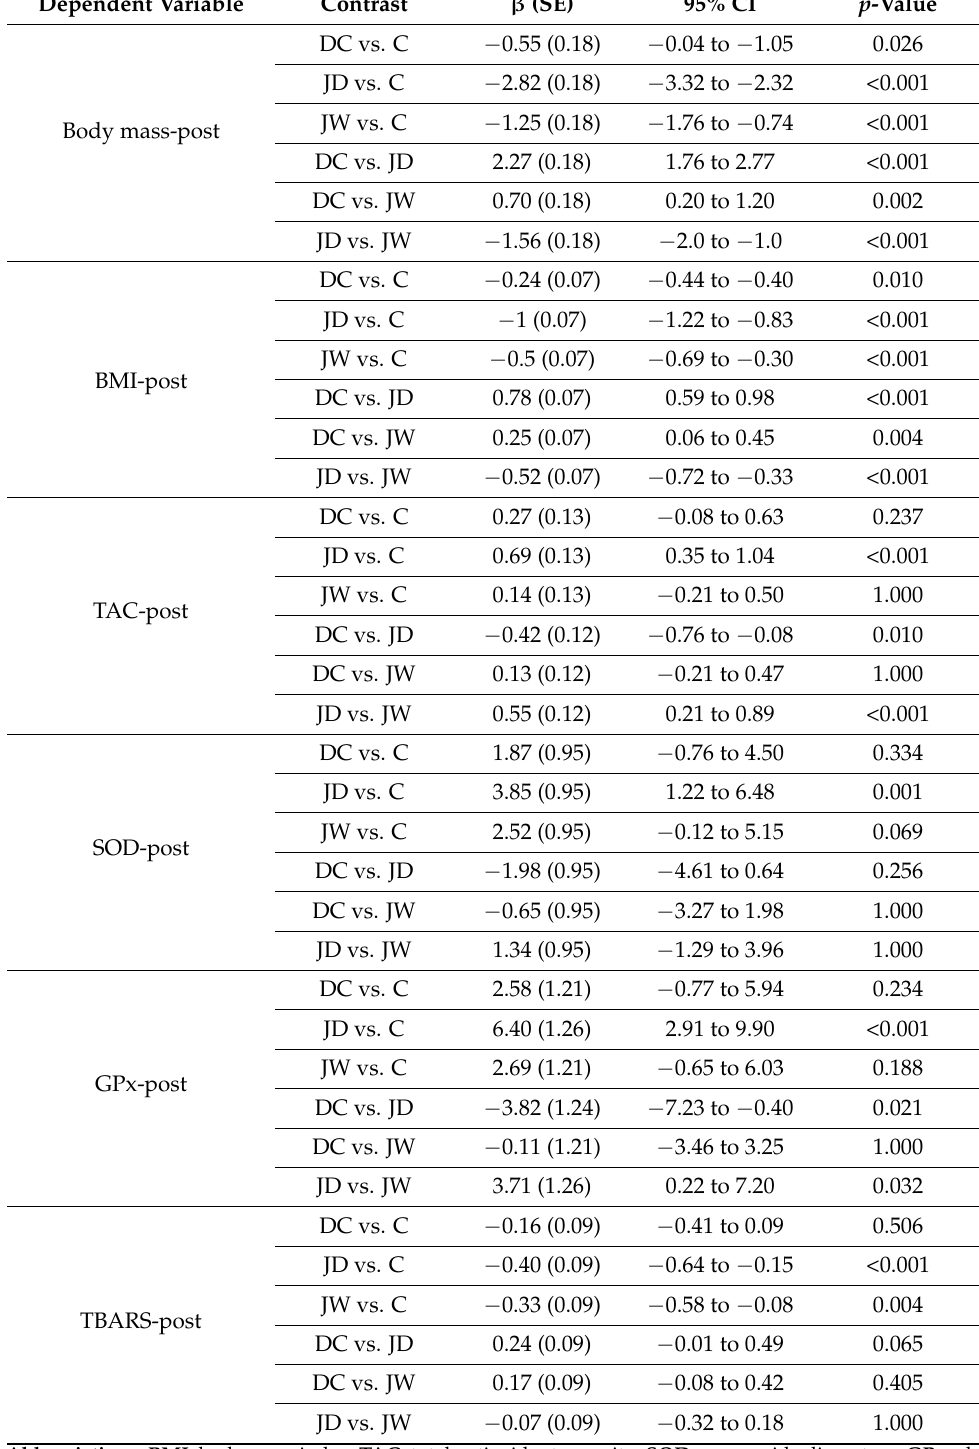
Table 4. The impact of group on the post values controlling pre values using ANCOVA and Bonferroni as multiple comparison